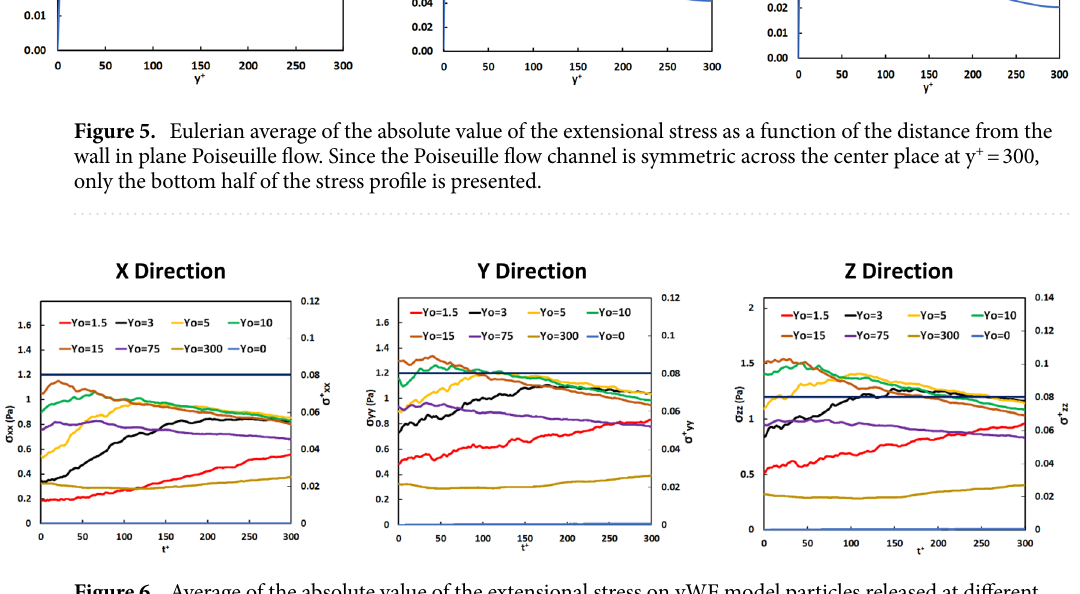
Figure 6. Average of the absolute value of the extensional stress on vWF model particles released at different positions in the Poiseuille flow field. The solid straight line at 1.2 Pa indicates the critical extensional